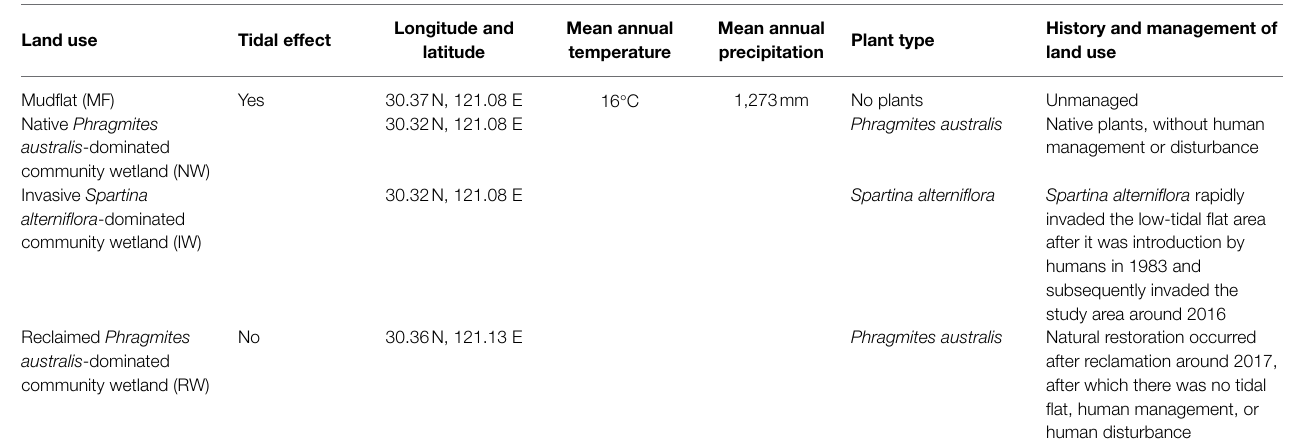
TABLE 1 | Description of four land-use types in the coastal wetland area of Hangzhou